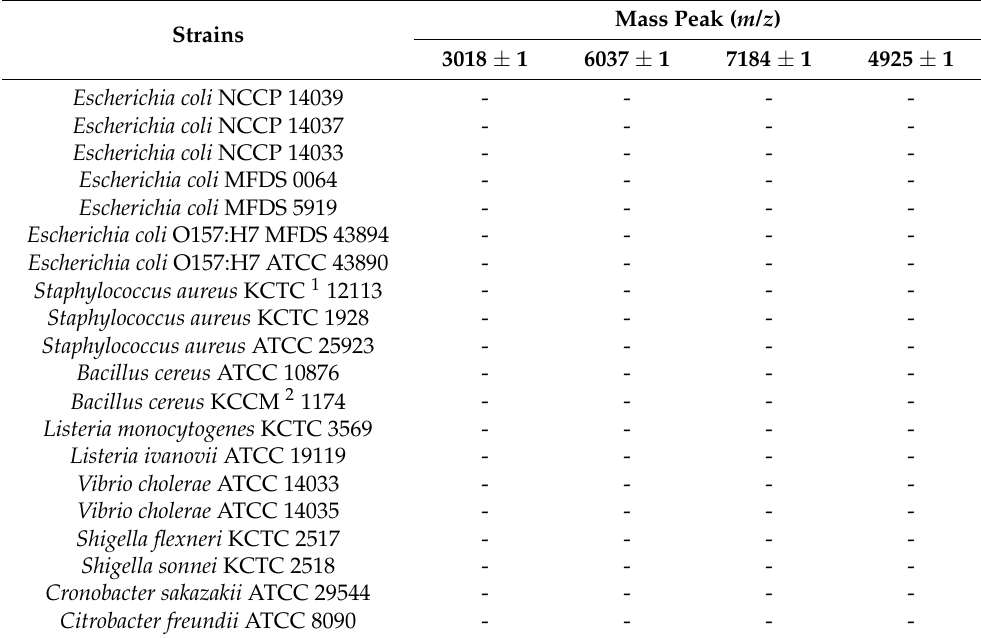
Table 4. Presence/absence of specific peaks for 20 other pathogenic bacterial strains.